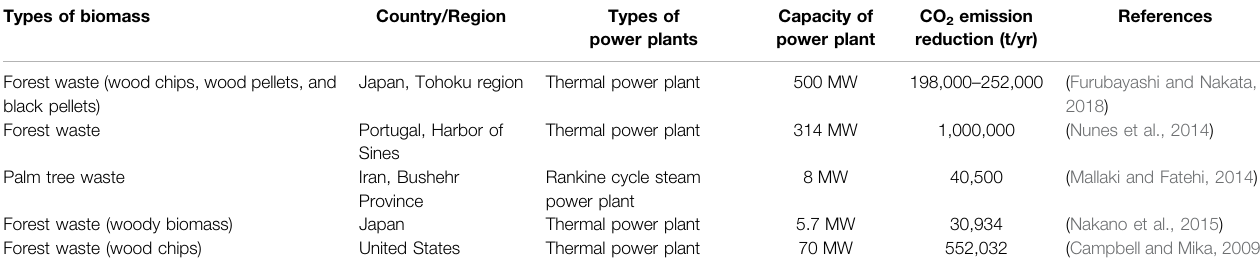
TABLE 2 | CO 2 emission reduction potentials of biomass-based power plants compared to their fossil fuel-based counterparts. Types of